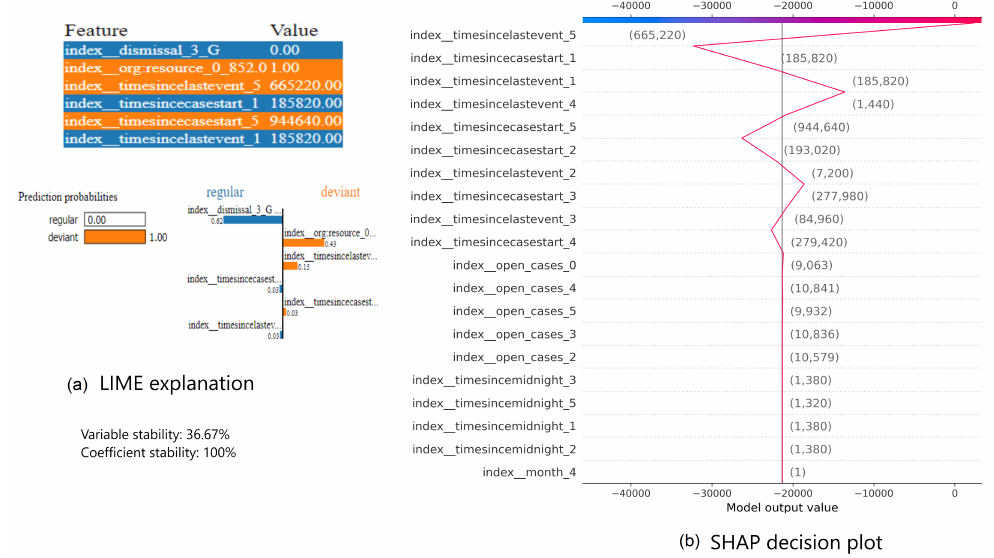
Figure 12. LIME vs. SHAP explanations of LR prediction for one instance in Traffic_fines preprocessed with prefix index